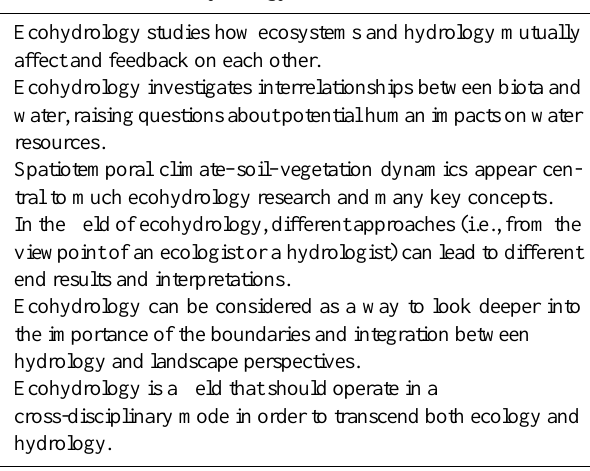
Table 2. Selected central concepts of ecohydrology identified by students with regards to ILO #1 in the course Ecohydrology: A Mediterranean perspective